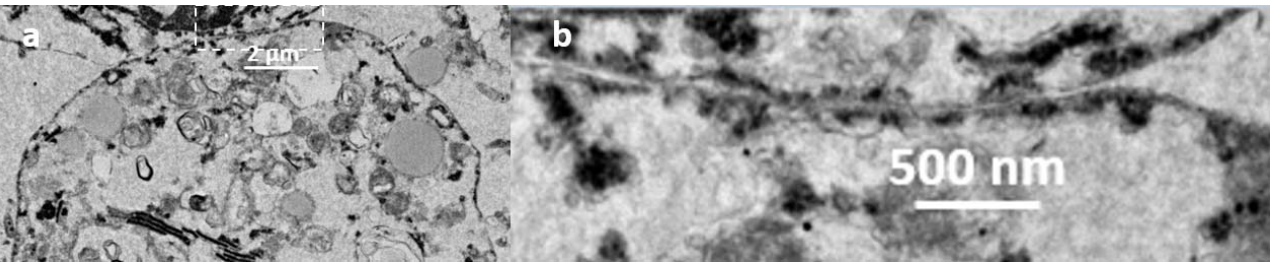
Figure 13. ( a ) Transmission electron micrograph of a large granular BmVIII ‐ SCC cell on day 85 of culture with gelatinous beads in a bioreactor highlighting with demarcation the putative cell ‐ cell junction with another tick cell ( b ) Transmission electron micrograph of a large granular BmVIII ‐ SCC cell on day 85 of culture with gelatinous beads in a bioreactor showing a higher magnification of putative cell ‐ cell junctions with opposed dense regions suspected to include proteins that anchor the cells together and possibly regulate cell ‐ cell transport.